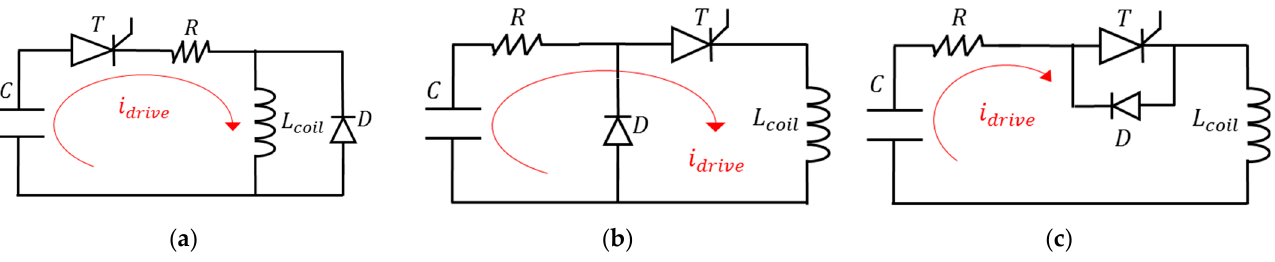
Figure 11. Single pulse control circuits of TCA. ( a ) Single pulse drive circuit freewheeling the coil;